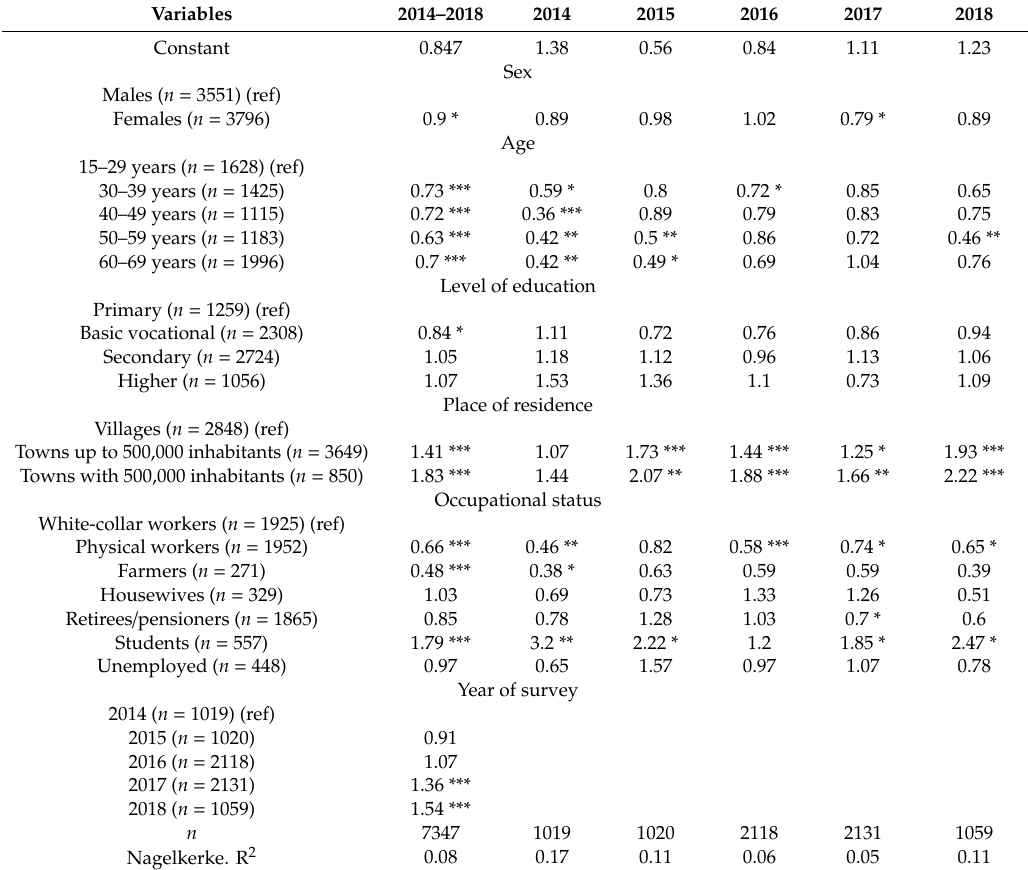
Table 4. Binary logistic regression for meeting WHO recommendations in physical activity among Polish society 2014–2018, in odds ratios [Exp( β